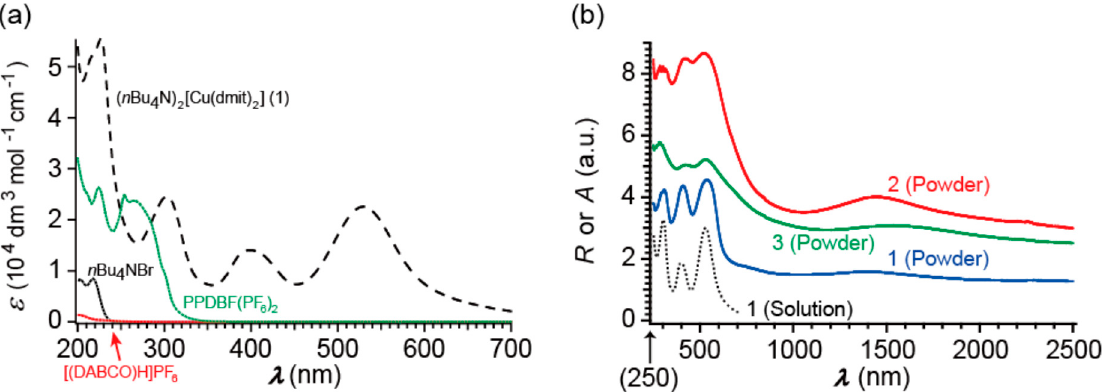
Figure 8. Solution and powder spectra for 1 – 3 (20 °C). ( a ) UV-VIS absorption ( ε ) spectra in CH 3 CN for 1 – 3 ; ( b ) UV-VIS-NIR diffuse reflectance ( R ) spectra in KBr pellets for 1 – 3 . The solution spectrum ( A ) for 1 (same spectrum as that in ( a )) is also shown for comparison.